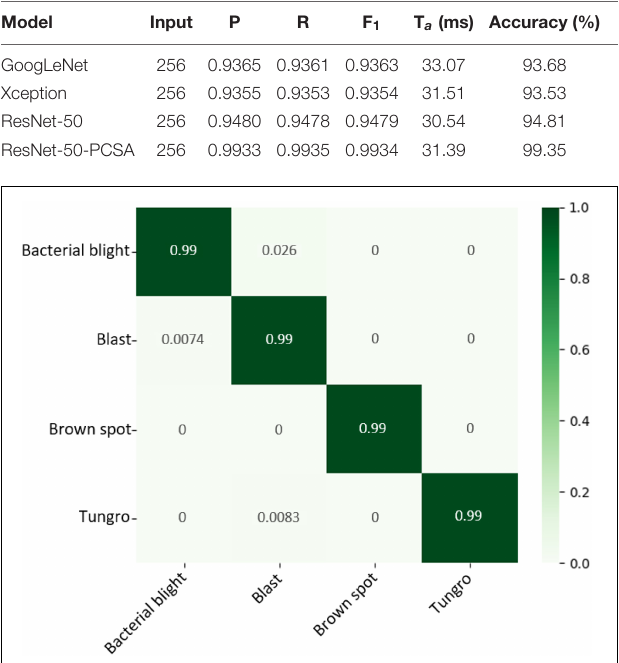
FIGURE 12 | Confusion matrices for rice leaf